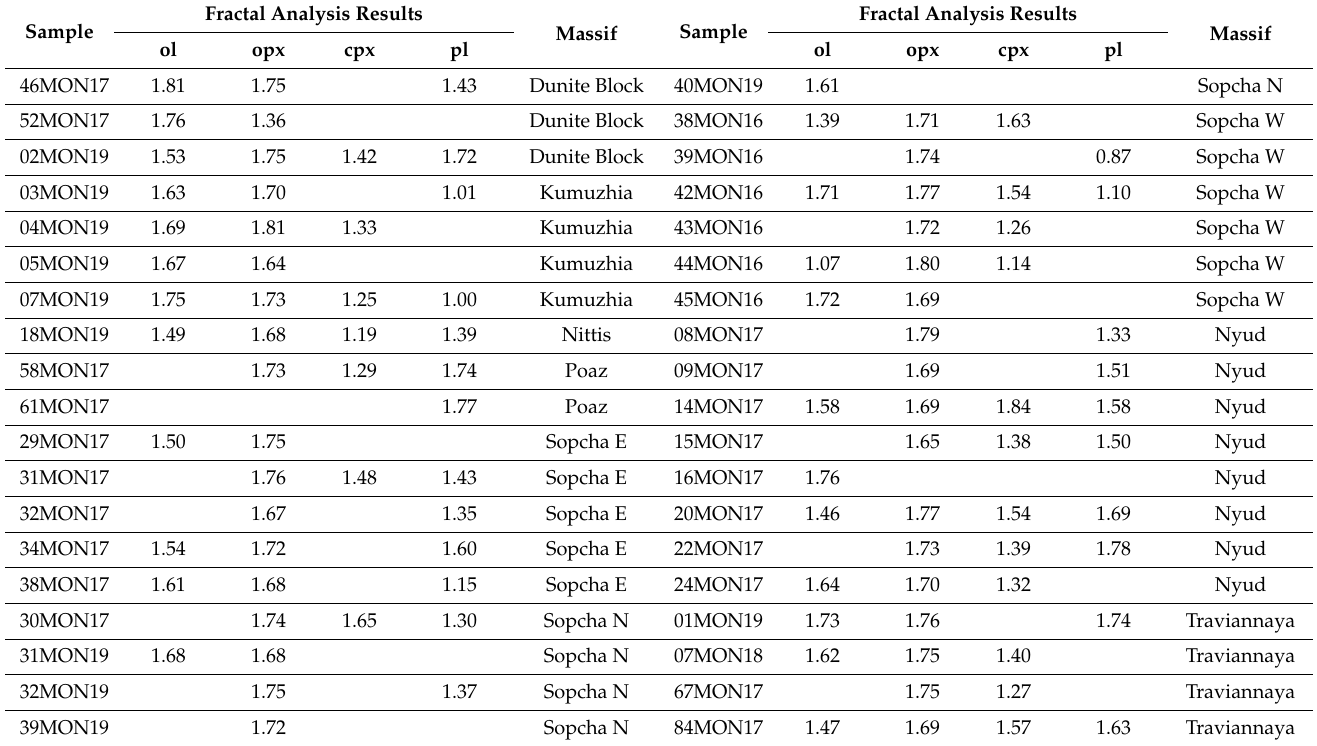
Table 2. Fractal dimension results calculated for individual types of